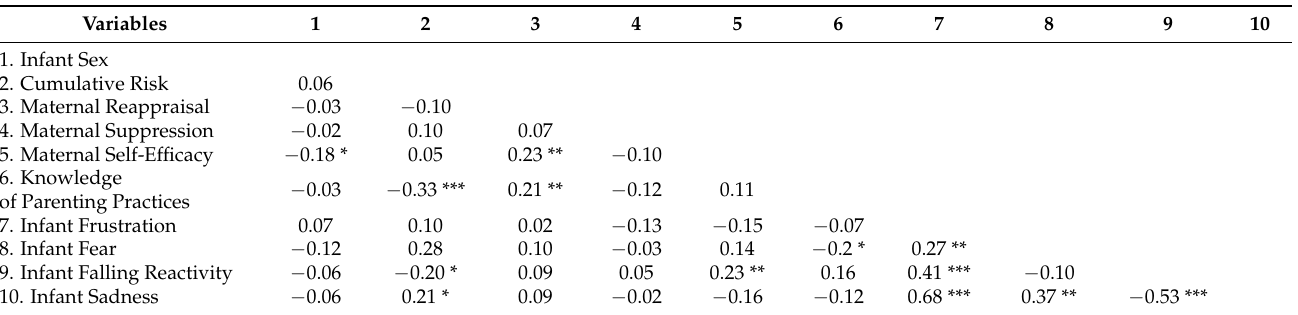
Table 1. Zero-order Correlations Between